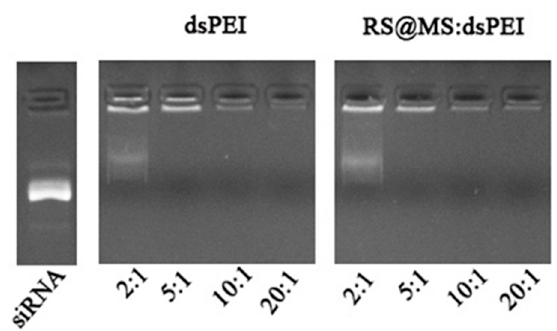
Figure 6. Agarose gel electrophoresis assay of PEI 25000 /siRNA dsPEI/siRNA, and RS@MS:dsPEI/siRNA at different N/P ratios.